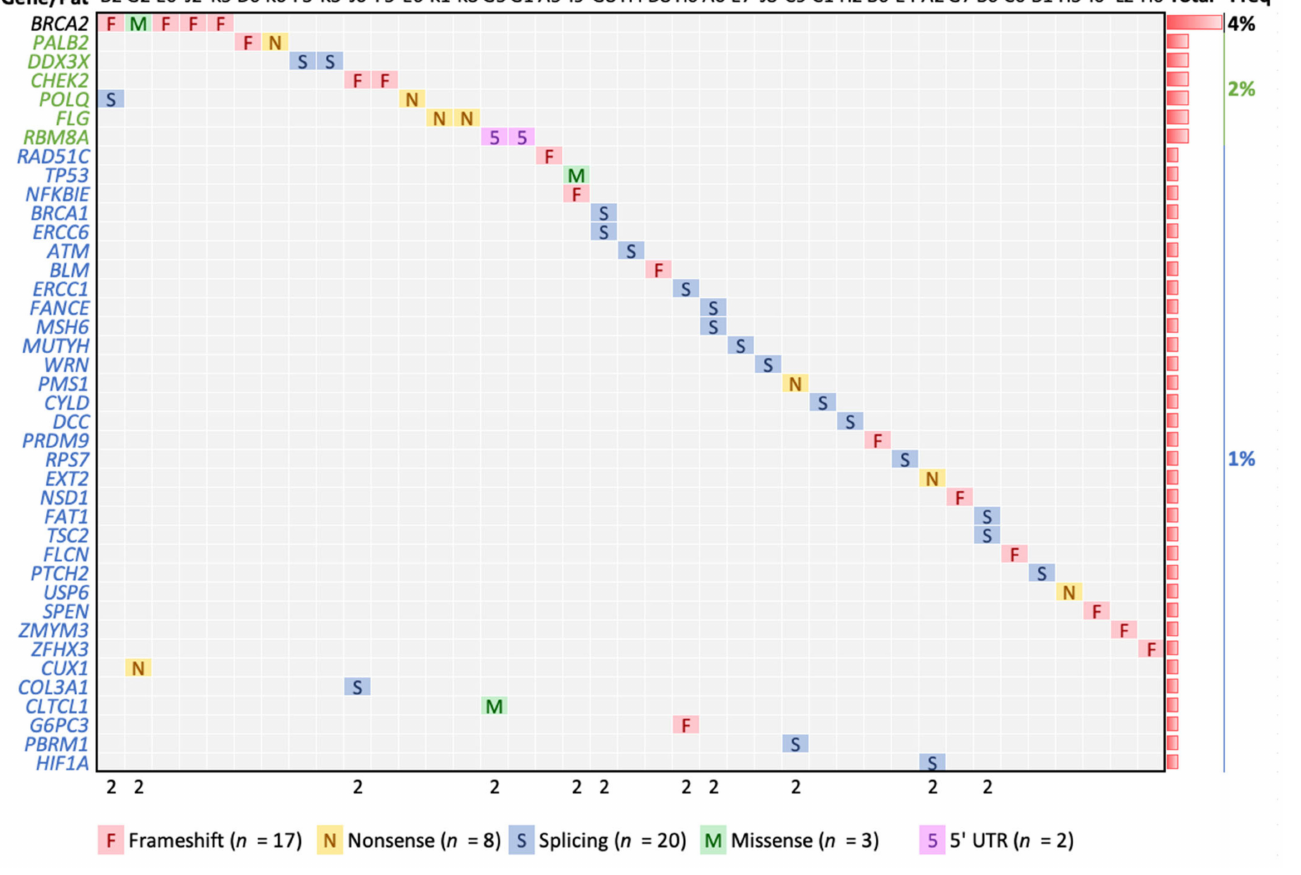
Figure 2. Gold variants detected. The top seven genes show two or more patients affected (black and green), while the rest show one patient only (blue). The 11 patients (in columns) marked with “2” show two Gold